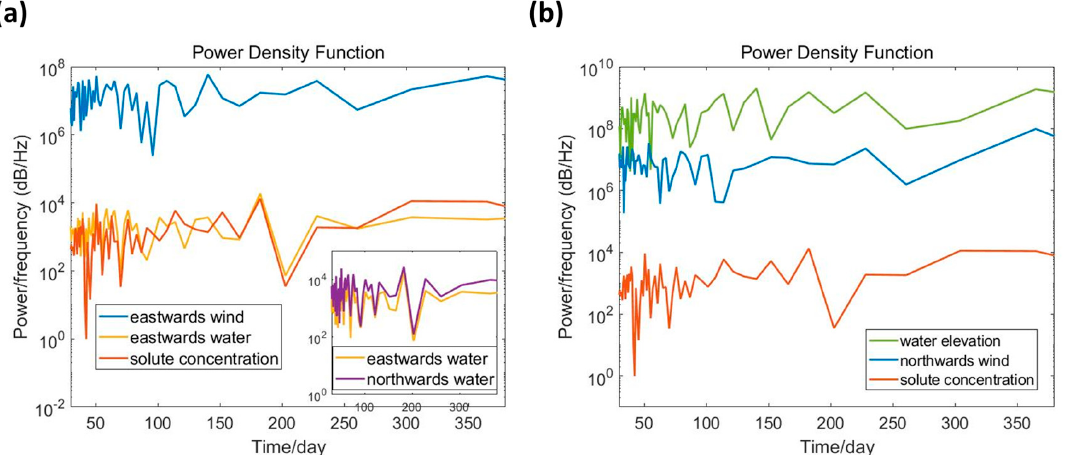
Figure 5. PSD analysis for the Vistula River coast case. ( a ) PSDs of relatively strongly correlated variables; ( b ) PSDs of weakly or not correlated